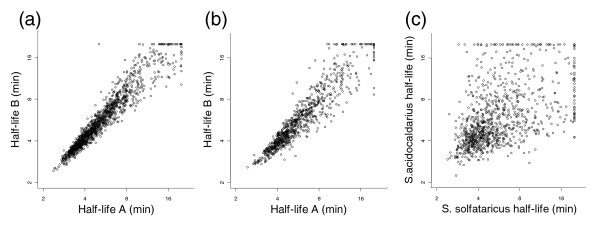
Comparison of mRNA half-lives obtained in (a) two independent labeling and hybridization assays, and (b) two independent cultures of the same species. (c) Comparison of mRNA half-lives of orthologous genes in S. solfataricus and S. acidocaldarius. Half-lives are shown in log2-scale.